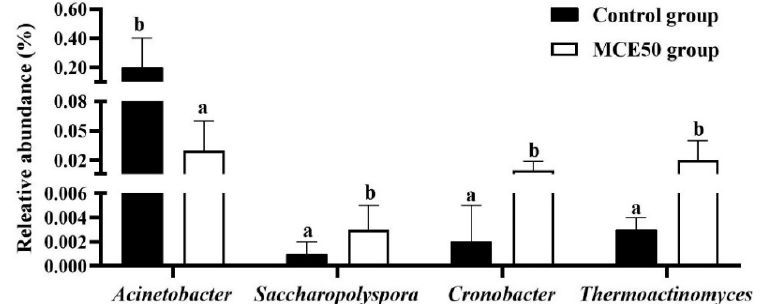
Figure 3. Comparison of differential bacteria at genus level in the intestine of juvenile American eels between the control group and MCE50 group. a,b Different superscripts on the bar are significantly different ( p <